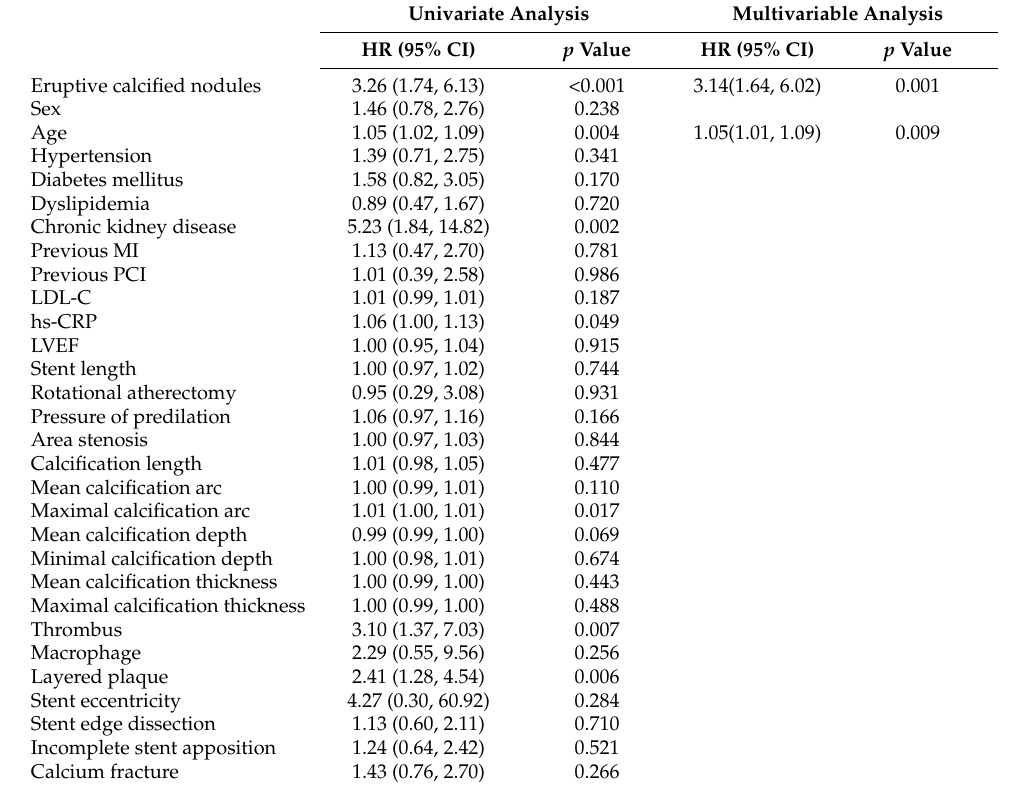
Table 5. Univariate and multivariate Cox proportional hazards model for predictors of